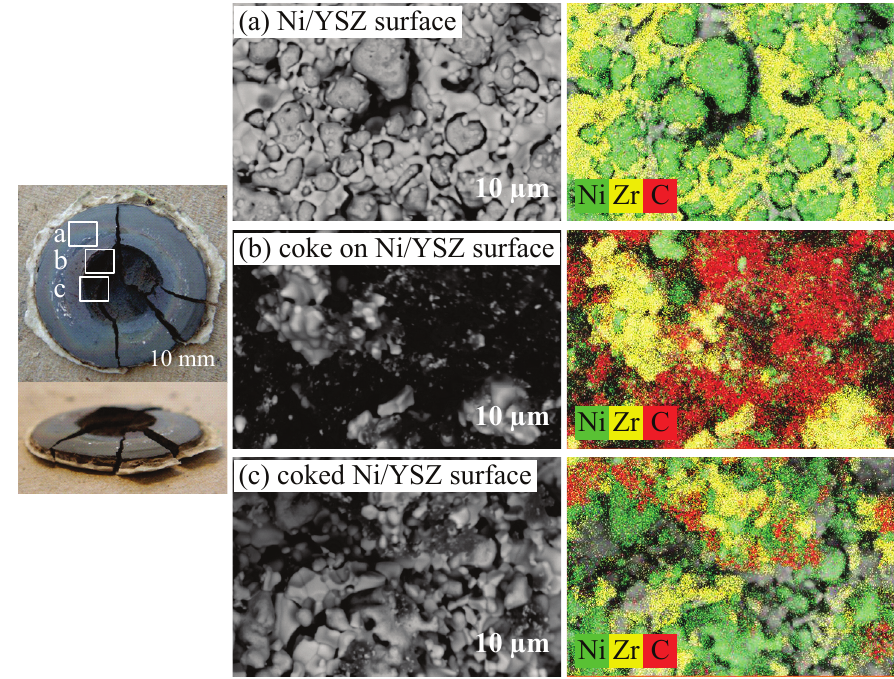
Figure 6. The Ni/YSZ anode fuel cell image and scanning electron microscopy (SEM) micrograph/ EDX mapping of the ( a ) Ni/YSZ surface; ( b ) coke that is deposited on the Ni/YSZ surface; and ( c ) coked spot on the Ni/YSZ surface after stability test in CH